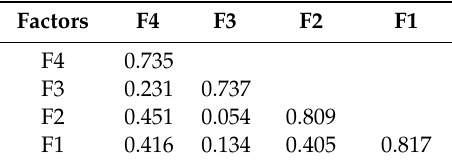
Table 9. Discriminant validity test of the identified